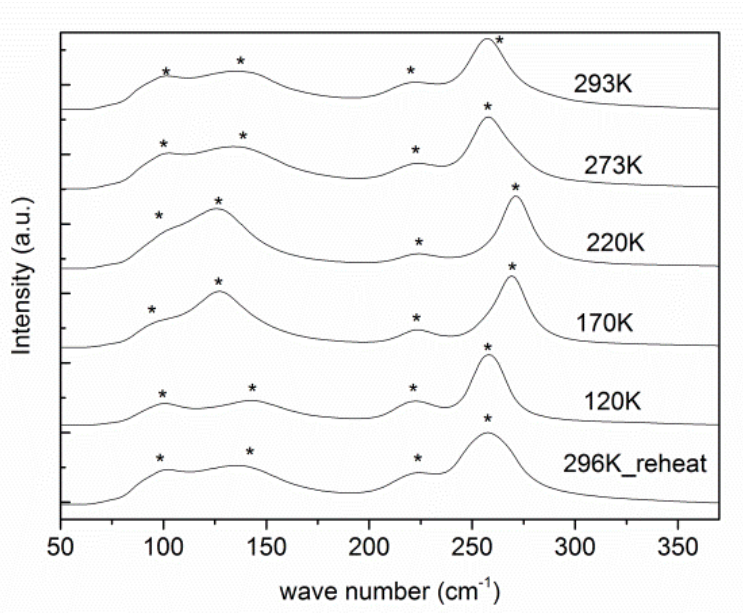
Figure 3 . VT Raman spectra during cooling for (MA) 2 KBiCl 6 . The peaks are highlighted by *.